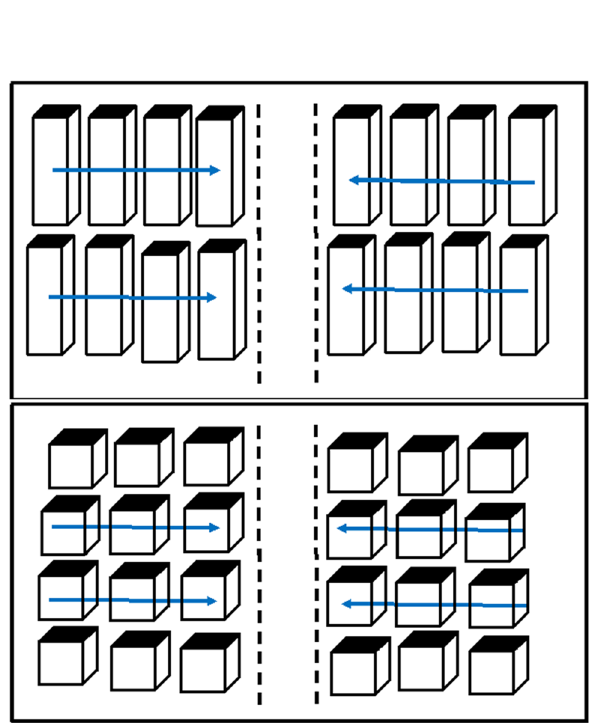
Fig. 7 Simple idealized geographic models used in this